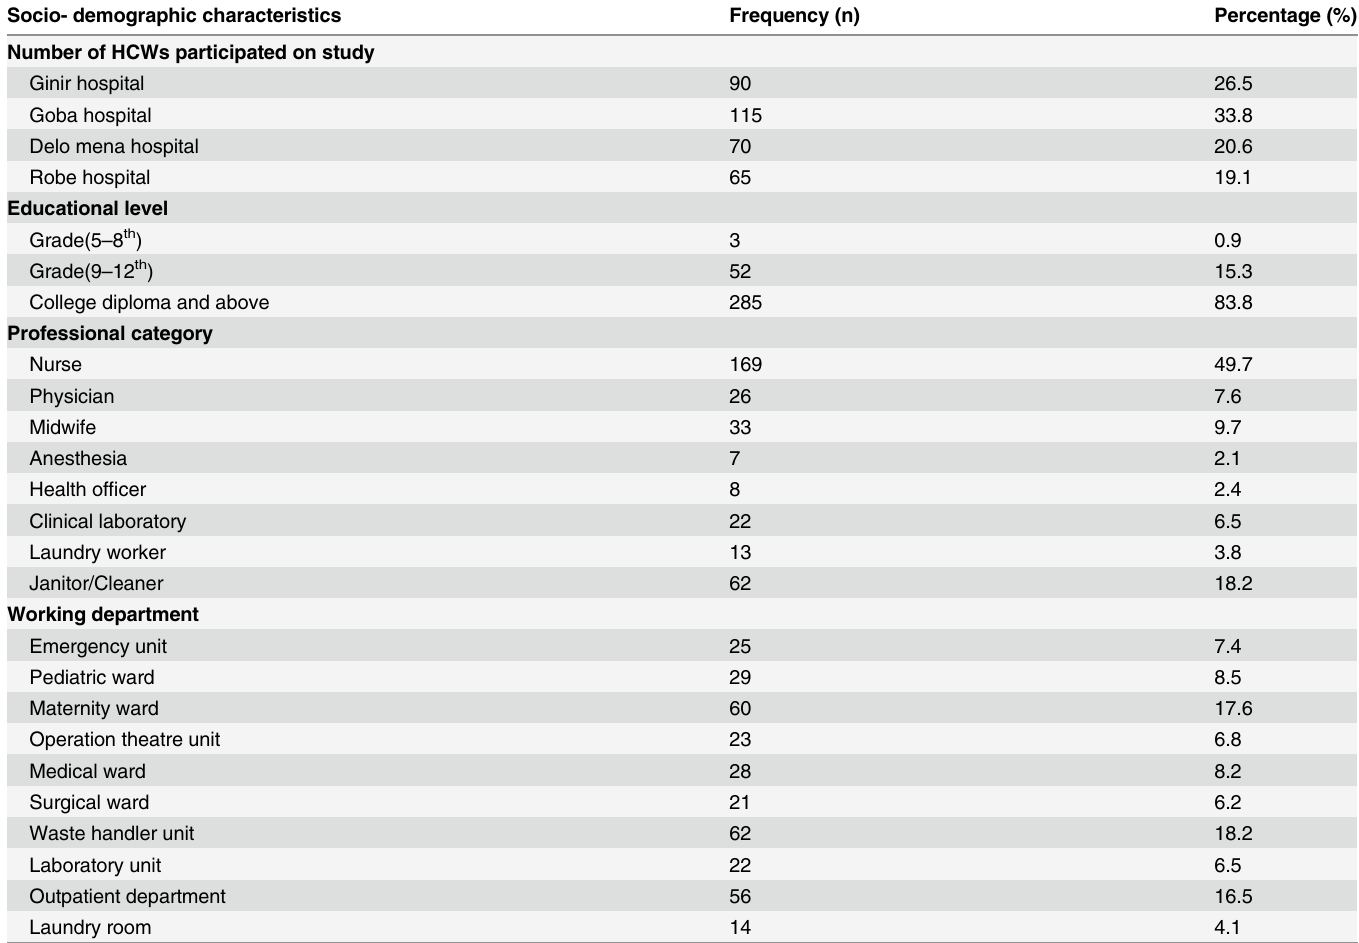
Table 1. Socio-demographic characteristics of hospital healthcare workers in Bale zone, December, 2014 (n =